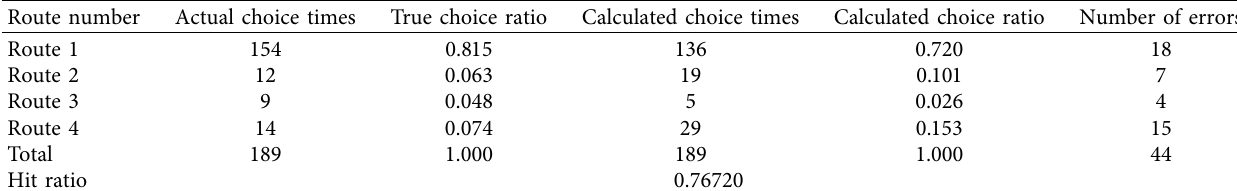
Table 8: Medium-distance passenger-carrying route choice model verification results.